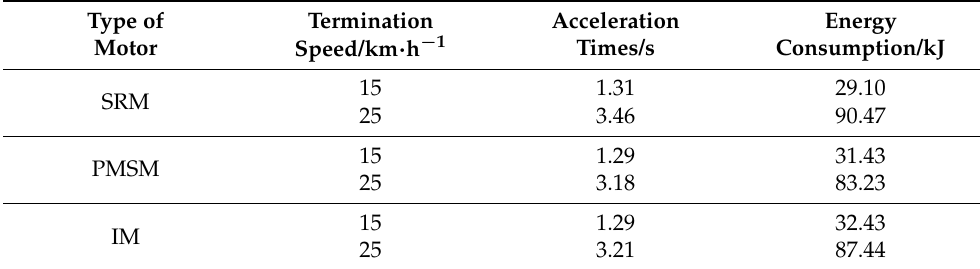
Table 8. Acceleration performance of three kinds of